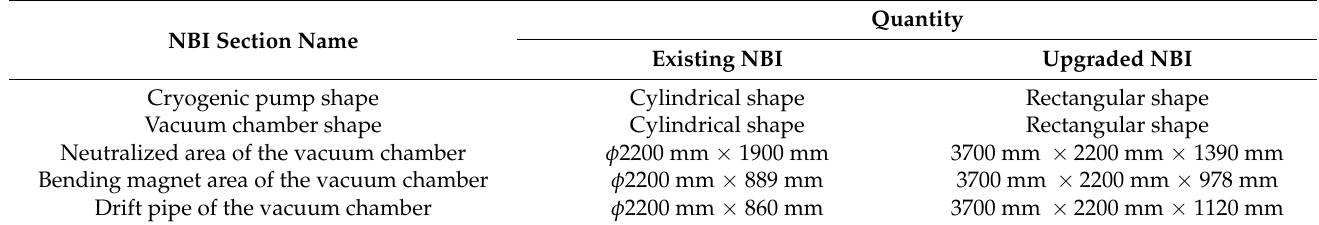
Table 1. Comparison of the dimensions of the beam-line vacuum chamber before and after the upgrade.